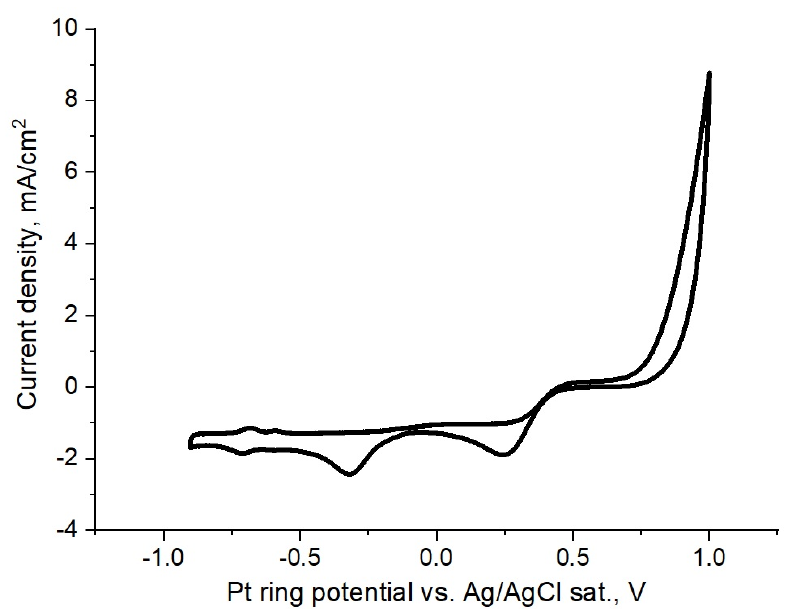
Figure 5. Cyclic voltammograms of 0.1 M OBr − recorded at 50 mV/s on the stationary platinum